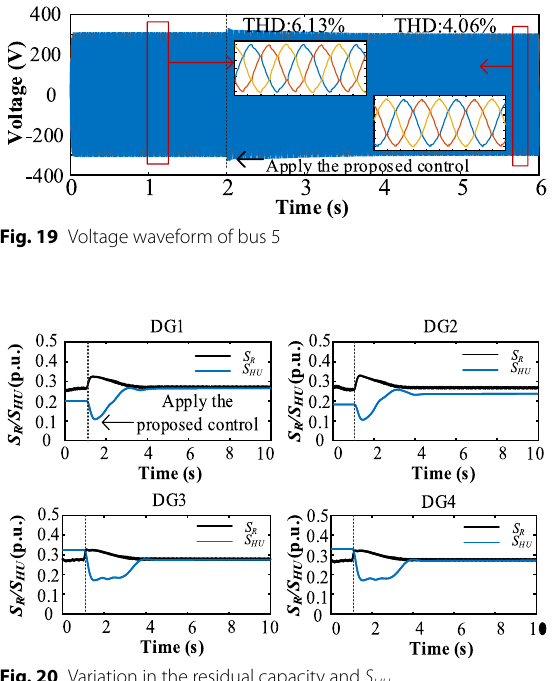
Fig. 20 Variation in the residual capacity and S HU